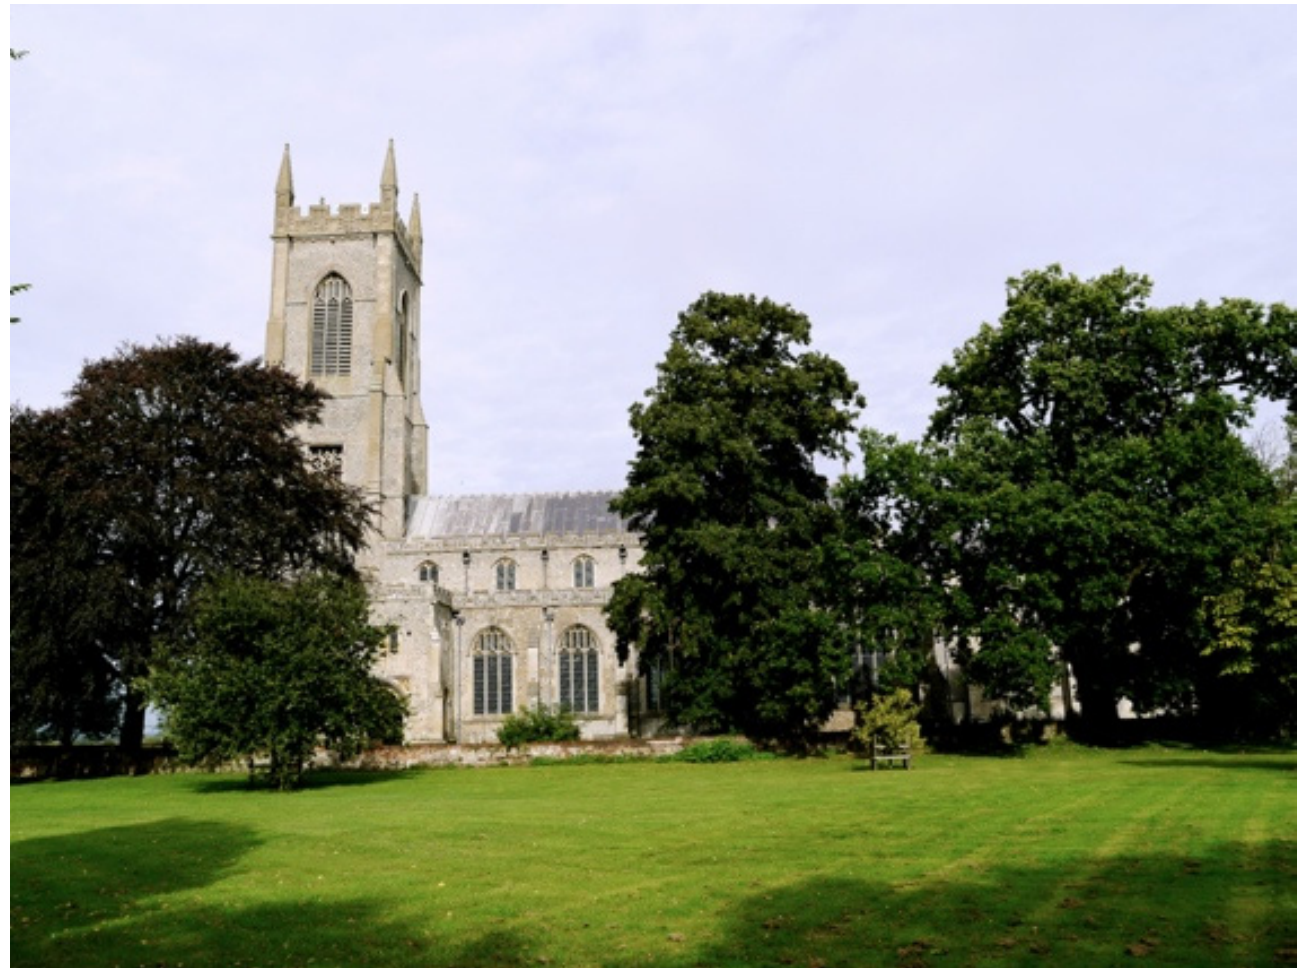
Figure 1. The church of St Peter and St Paul at Salle.